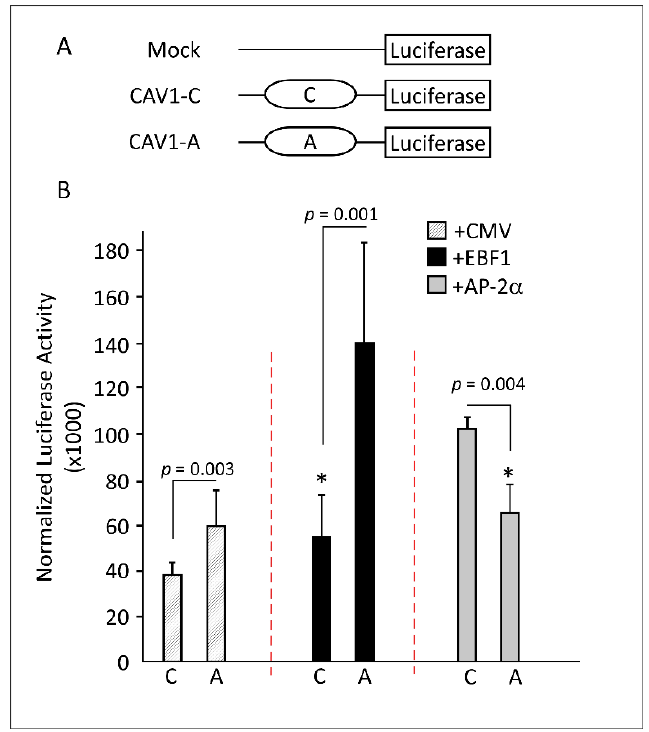
Figure 3. Promoter activity analysis using wild-type versus the rs1997623 variant luciferase reporter assays. ( A ) A schematic representation of the CAV1 gene mapping the rs1997623 variant to intron 1; the cloned 250 bp DNA fragment spanning the CAV1 indel rs1997623 into Luciferase-pRMT-Luc reporter vector as well as the generated C > A mutant are shown. ( B ) Luciferase reporter assay of rs1997623. Pre-adipose cells transfected with CAV1-C-Luc or CAV1-A-Luc constructs and co-transfected with control plasmid (shaded bars), EBF1 (black bars), or AP-2 α (gray bars) constructs. Luciferase activities are presented as folds change relative to the pRMT-Luc reporter. Transfection efficiency was monitored by assaying the activity of co-transfected Renilla luciferase. p -values are given when comparing CAV1-C-Luc to CAV1-A-Luc transfections with or without EBF1 and AP- 2α. * Indicates nonsignificance relative to the reciprocal CMV plasmid transfection. Data are presented as mean ± standard error of the mean (SEM) and the p- value of a two-tailed unpaired t -test. Taken together, the above results indicate that the promoter located in the 250 bp of the CAV1 regulatory region is transcriptionally active in preadipocytes and that its activity